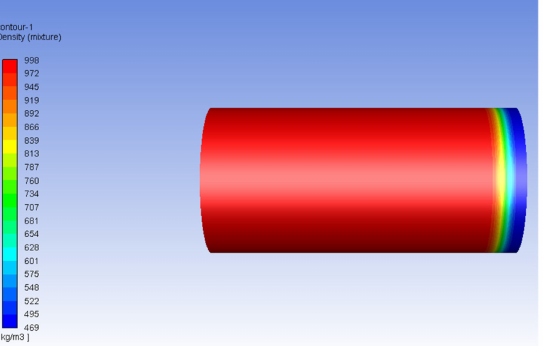
Figure 14. Density profile across the core—supercritical carbon dioxide inlet pressure 10.1 MPa. Figures 15 and 16 show the flow characteristics within the sandstone core after 10 s from start at pressures of 10.1 MPa and 20.2 MPa, respectively. The density of supercritical carbon dioxide increases significantly from 10.1 MPa to 20.2 MPa and, therefore, more water is displaced by the latter after 10 s.